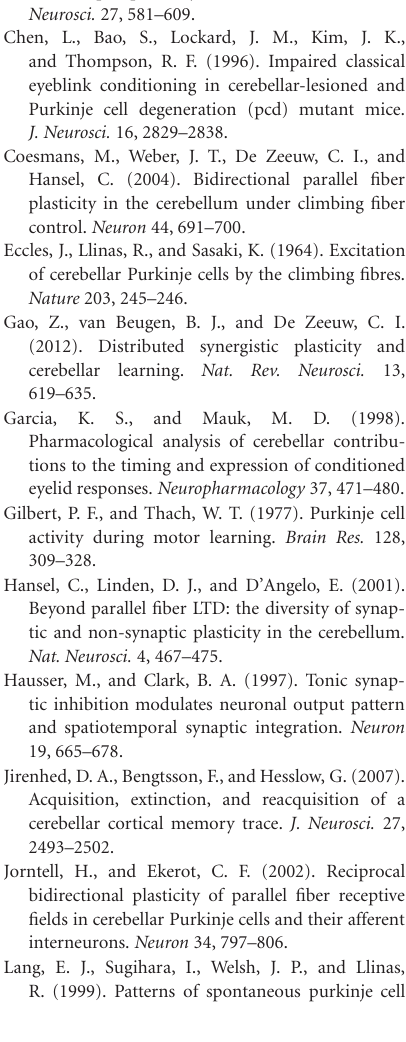
text, for at least two of the three sites the physiological details of the CF input, the underlying cellular mechanisms of plasticity, and the relative contribution to behavioral learning remain to be elucidated. (B) ChR2-eYFP expressing CFs are visible in this multi-photon microscopic image of part of folia X in a 300 µ m thick rat brain